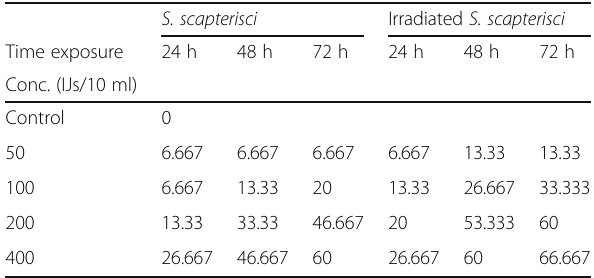
Table 1 Accumulative percentage mortality of the third instar Culex pipiens larvae infected by non-irradiated and irradiated Steinernema scapterisci